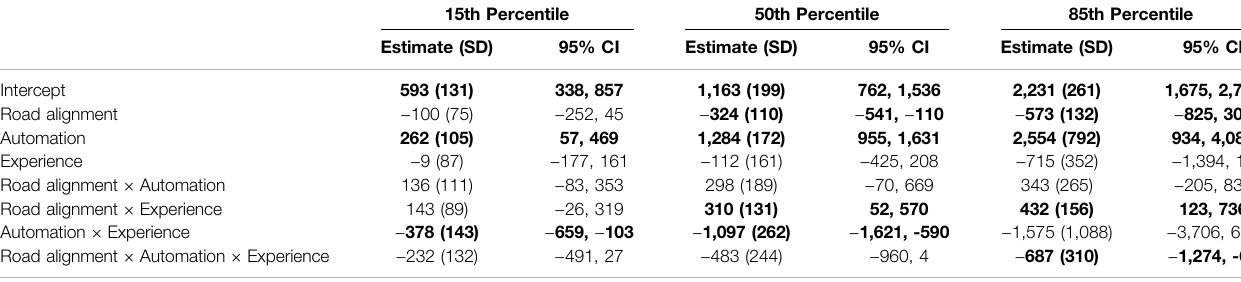
TABLE 2 | Quantile regression results; signi fi cant ( p < 0.05) fi ndings are bolded; SD: standard deviation, CI: credible interval.